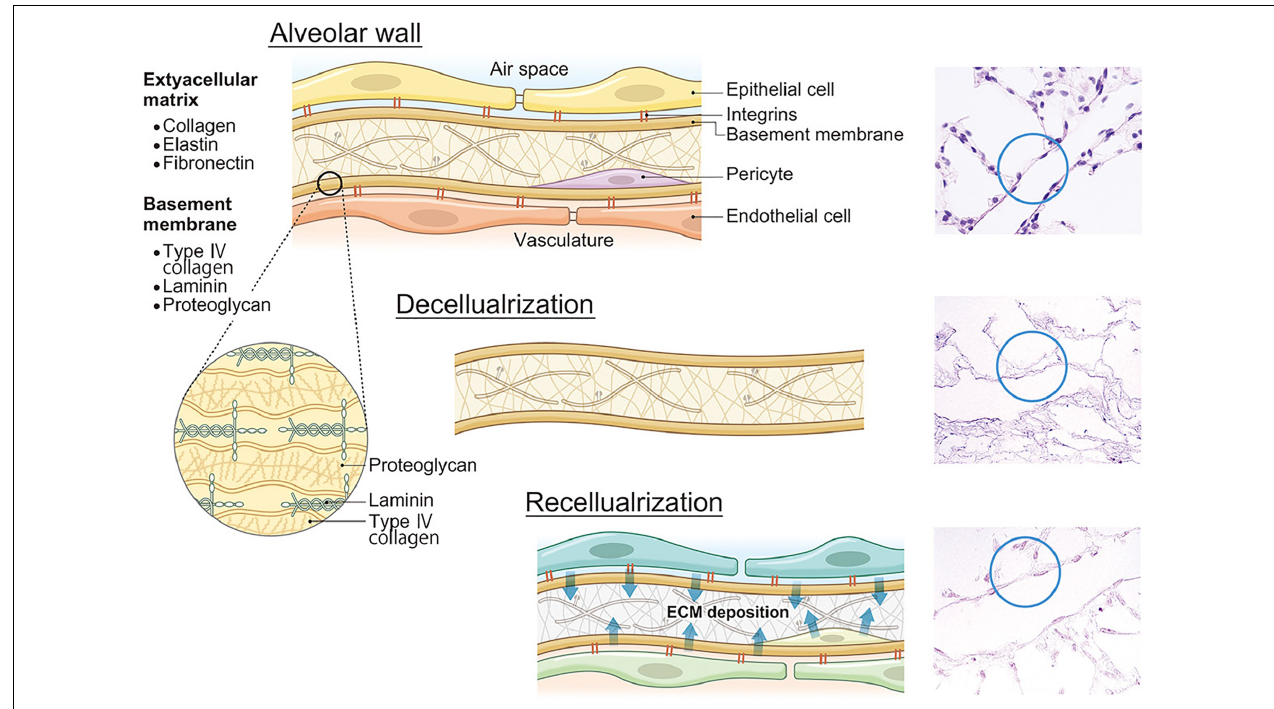
FIGURE 2 | ECM decomposition and reconstruction after recellularization. Lung ECMs consist of collagens, elastin, fibronectin, laminin, proteoglycans, and other constitutive proteins. After lung decellularization, a certain level of ECM damage occurs during decellularization. However, after recellularization, seeded cells secrete own ECM proteins which will change the ECM composition and finally affect lung functions including microvasculature permeability. ECM, extracellular